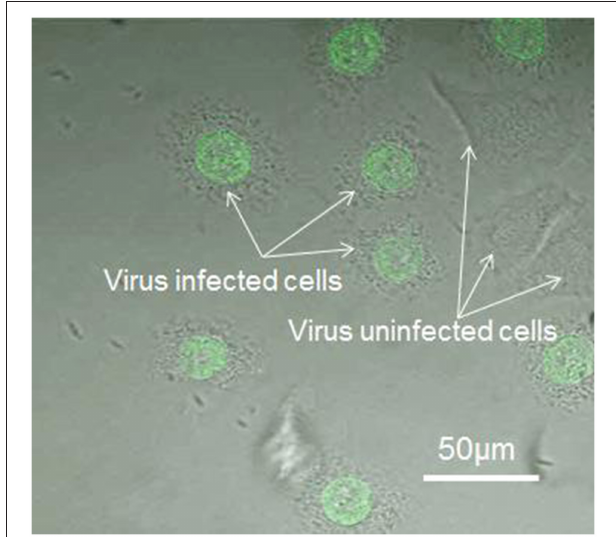
FIGURE 6 | Immunostaining of the virus-bound and -unbound cells (detected using anti-PB1 serum and an anti-rabbit IgG labeled with Alexa